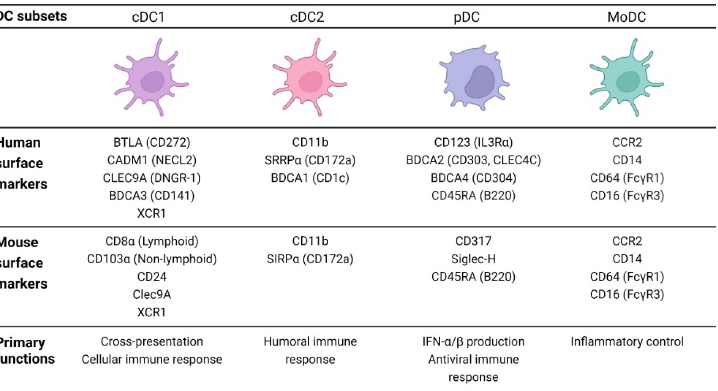
Figure 1. The distinct DC subsets with their respective surface markers (human and mouse) and primary functions. Markers can vary across tissues and depend on the physiological setting. cDC1, type 1 classical/conventional dendritic cell; cDC2, type 2 classical/conventional dendritic cell; pDC, plasmacytoid dendritic cell; moDC, monocyte-derived dendritic cell; BTLA, B and T cell lymphocyte attenuator; CADM1, cell adhesion molecule 1; CLEC9A, C-type-lectin 9A; BDCA3, blood dendritic cell antigen 3; XCR1, XC chemokine receptor 1; CLEC10A, C-type-lectin 10A; BDCA1, blood dendritic cell antigen 1; IL3R α , interleukin 3R α ; BDCA2, blood dendritic cell antigen 2; CLEC4C, C-type-lectin C4; BDCA4, blood dendritic cell antigen 4; Siglec-H, sialic acid-binding immunoglobulin-like lectin-H; CCR2, C-C motif chemokine receptor 2; Fc γ R1, Fc-gamma receptor 1; Fc γ R3, Fc-gamma receptor